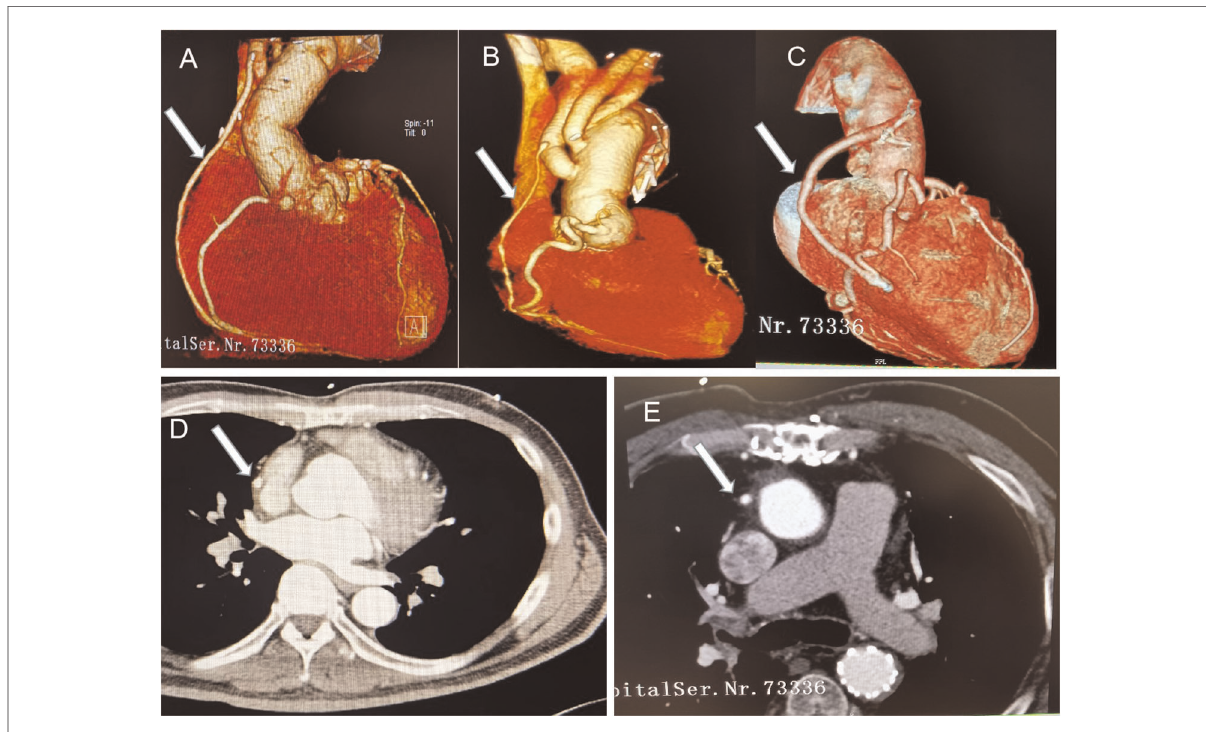
FIGURE 2 CT pictures in the follow-up time. Arrows indicate the SV bypass. ( A ) SV to RCA bypass+ hemi-arch replacement; ( B ) SV to PDA bypass + total arch replacement, SV bypass with obvious stenosis; ( C ) SV to right acute marginal artery bypass +hemi-arch replacement; ( C,D ) CT images of the SV